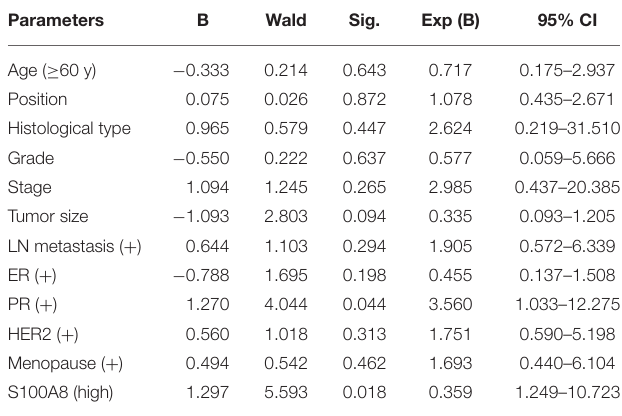
TABLE 2 | Logistic regression analysis of factors predicting recurrence in breast cancer patients ( n = 140). Parameters